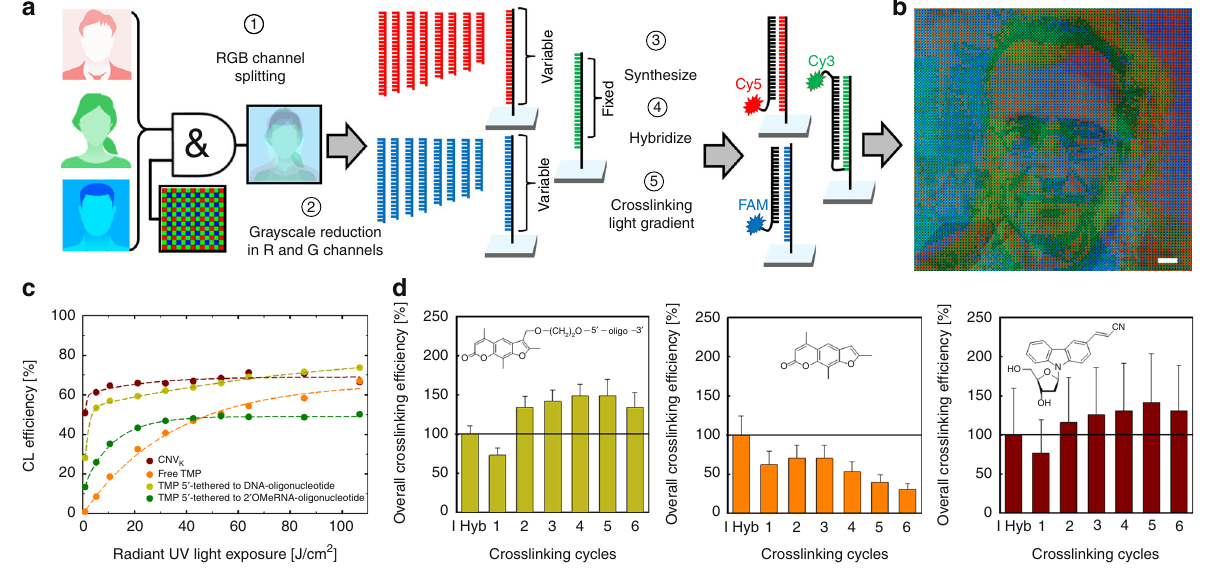
Fig. 3 Post-synthetic photochemical processing (Level-Two patterning). High complexity patterns can be superimposed after photolithographic synthesis, e.g., via hybridization and selective crosslinking. a Nucleic acid crosslinking steganography. Alternatively to oligonucleotides encoding all colors, color-wise ANDing with Bayer fi lter pattern separates each channel into independent pixels. Two channels (R & B) are encoded using a melting-temperature grayscale and the green channel is encoded using a single sequence followed by a light gradient to impose a grayscale through variable crosslinking ef fi ciency. b “ Hidden fi gure ” image of three Viennese physicists (200 µ m scale bar) is revealed with a green fi lter or by washing off the non-crosslinked red and blue channels (Supplementary Figure 7). c 365 nm UV light exposure gradients for CNV K-modi fi ed oligonucleotides (dark red), free psoralen (orange), psoralen- modi fi ed DNA oligonucleotides (light green) or psoralen-modi fi ed 2 ′ - O MeRNA oligonucleotides (dark green). d Crosslinking ef fi ciency for tethered and CNV K-modi fi ed oligonucleotides can be greatly increased with multiple hybridization/exposure cycles; percent values are relative to the fi rst hybridization. Error bars correspond to the standard deviation. Source data are provided as a Source Data fi